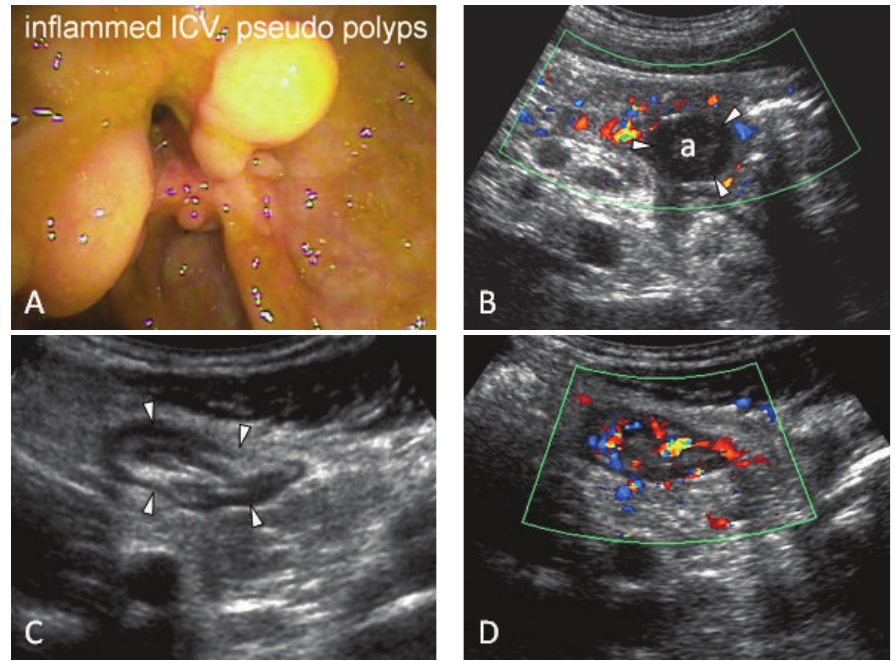
Figure5:NopriordiagnosisofCrohn’sdisease.17-year-oldmalepatientwithnopriordiagnosisofCrohn’sdisease.Colonoscopyisincomplete with a failure to intubate the inflamed ileocecal valve, shown in (A), with pseudopolyps. (B) Transabdominal ultrasound shows an interloop abscess cavity (a). (C) shows a thickened terminal ileum in axial view. The length of involvement (not shown) is 20cm. (D) shows hyperaemia on colour Doppler. Interpretation: acute inflammation of the terminal ileum with a small interloop abscess. Four days after the ultrasound, the patient was admitted to hospital for intravenous antibiotic